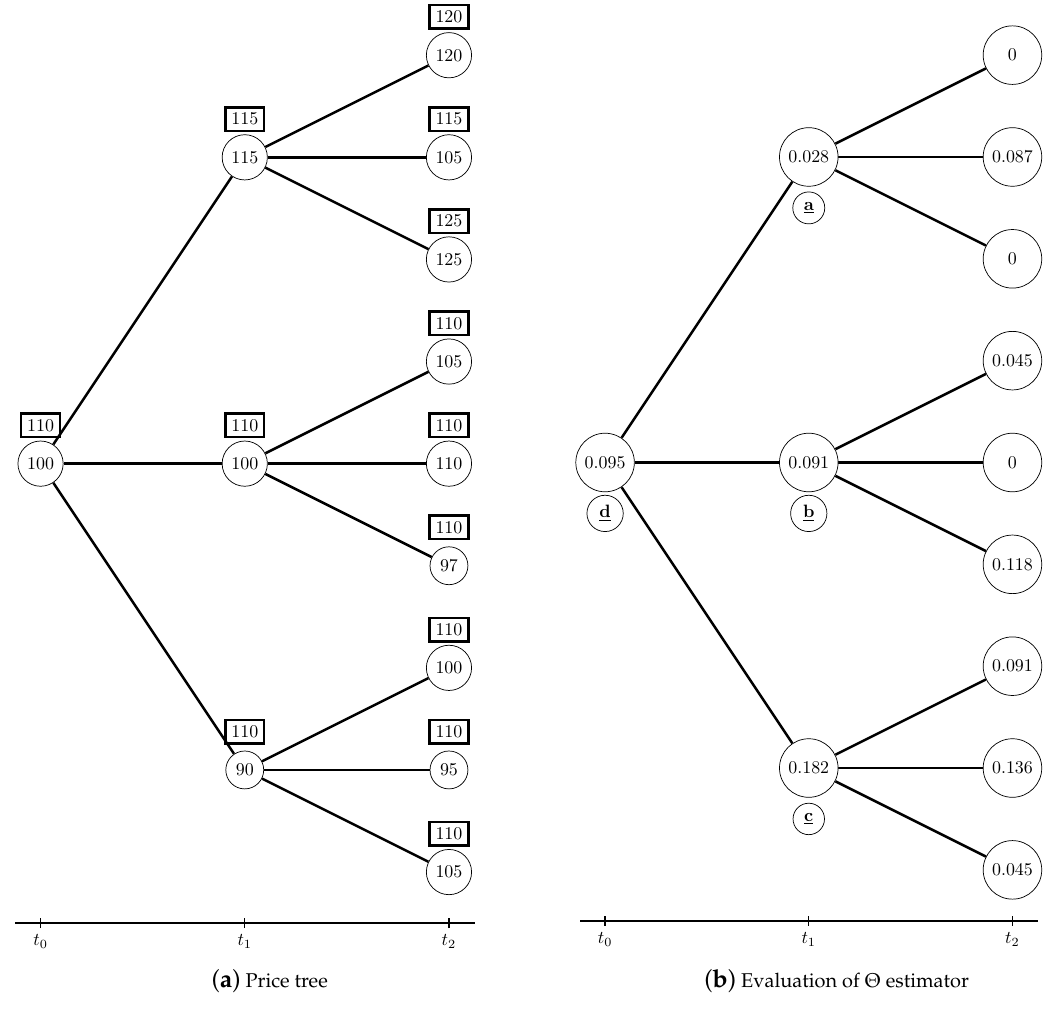
Figure 4. Explanation of Θ